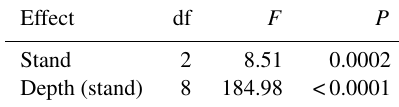
Table 5. Nested two-way analysis of variance to examine root diam- eter differences observed among the combination of four soil depths (10, 20, 30 and >30cm) and three forest stands ( Pinus cembroides , Quercus potosina and mixed forest) in a semiarid forest ecosystem in central-north México. Effect df F P Stand 2 8.51 0.0002 Depth (stand) 8 184.98